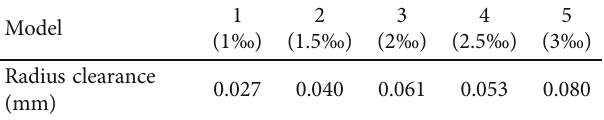
Table 11: Radius clearance of SFD